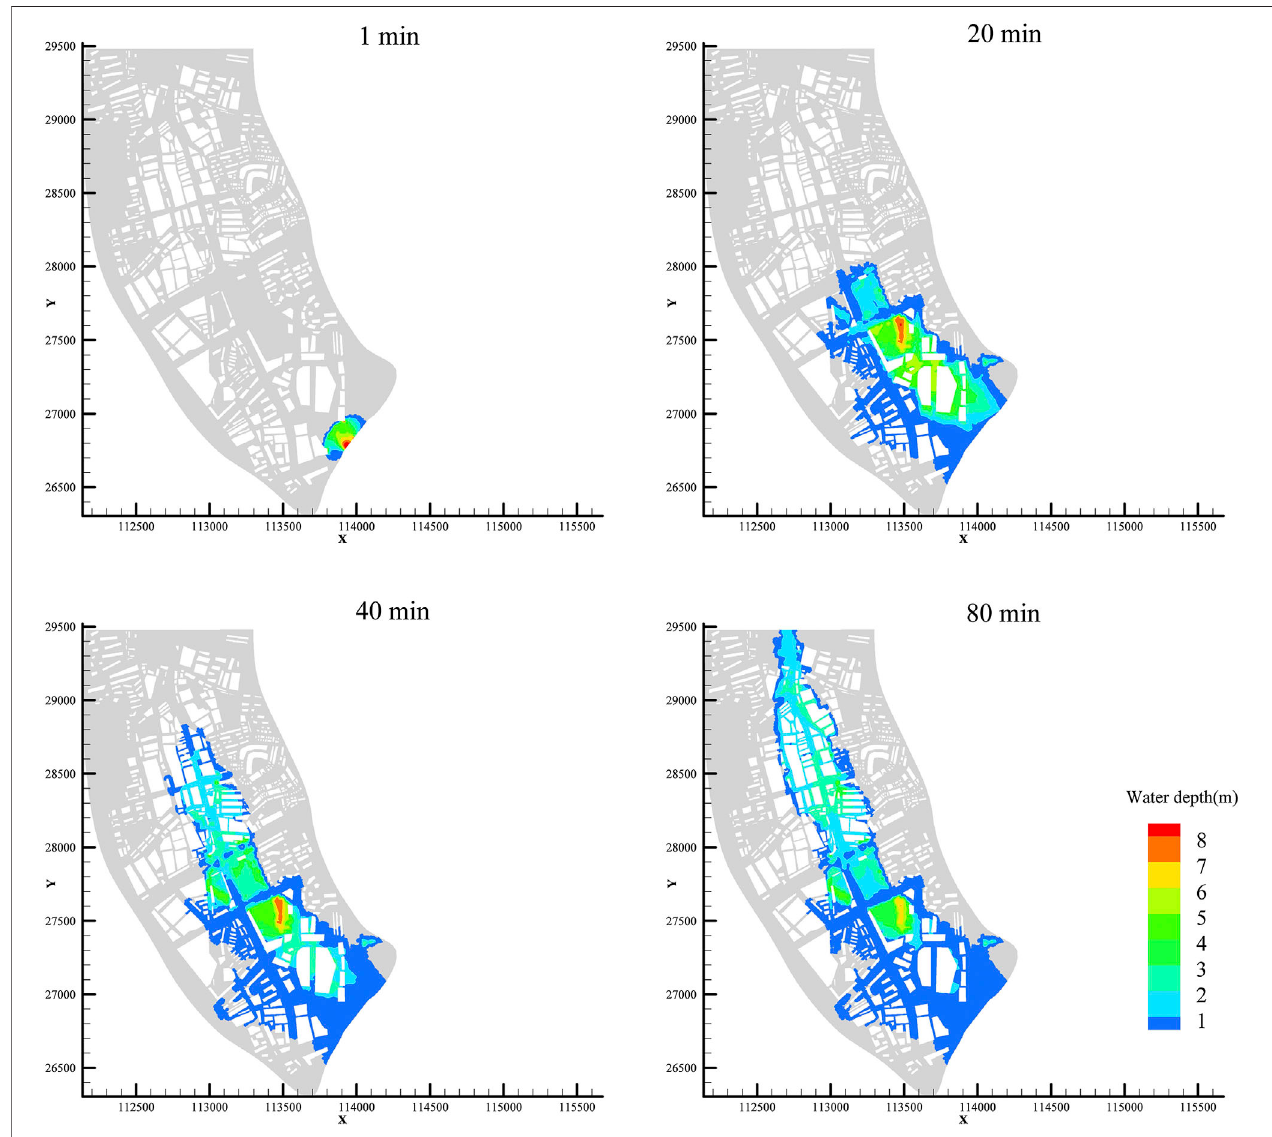
FIGURE 3 | Inundation extent under condition 3 at 1, 20, 40, and 80